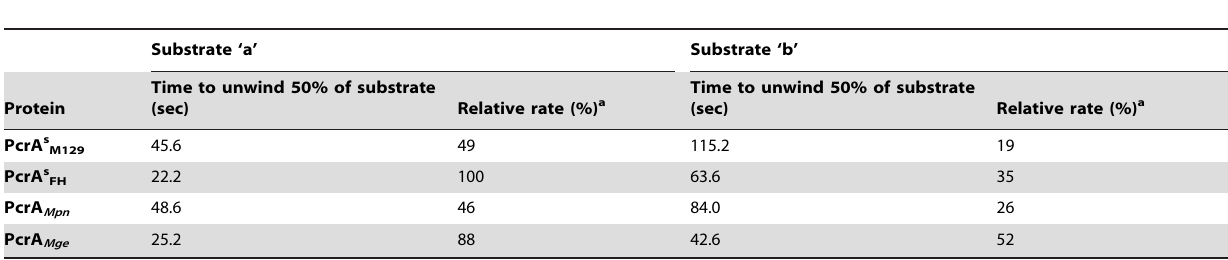
Table 2. Relative rate of the DNA helicase activities of PcrA s M129 , PcrA s FH , PcrA Mpn and PcrA Mge .